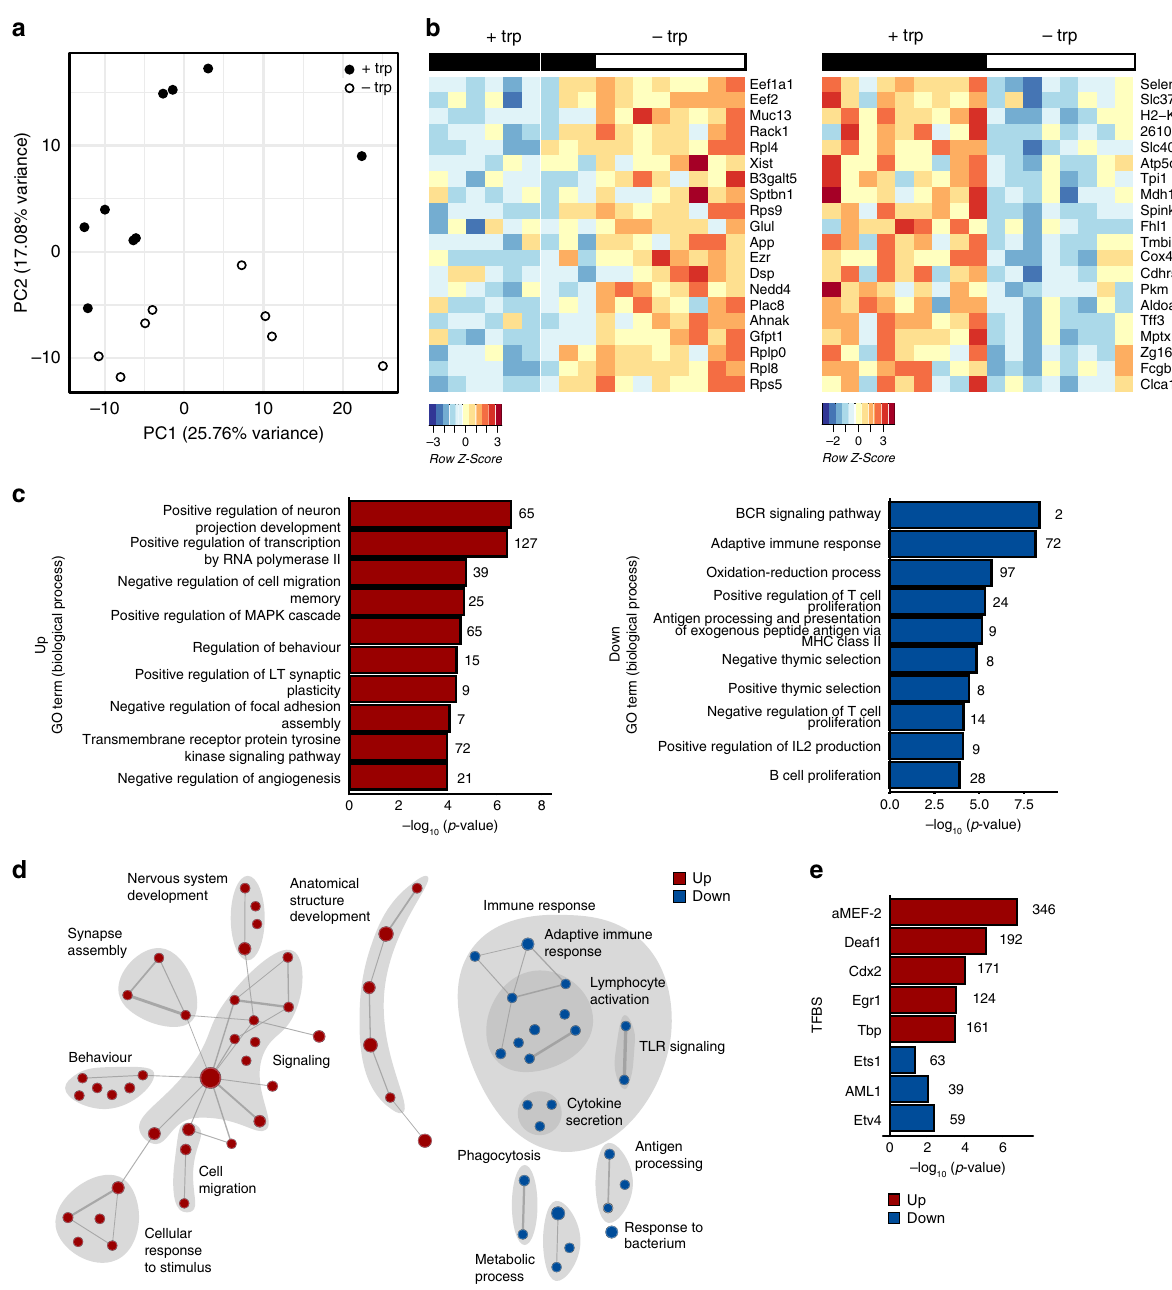
Fig. 6 DTR regulates key molecular signaling pathways in colon mucosa. a – e Total colon tissue (distal) of EAE mice from Fig. 5 was isolated on d14 for RNA sequencing ( + trp: n = 9; − trp: n = 9). a Principal component analysis (PCA) for RNA sequencing samples. b Heatmap of top 20 DEGs (up and down) in pair-wise comparisons between – trp and + trp. c Top 10 pathways (biological processes) of Gene Ontology (GO) enrichment analysis. d Enrichment map of regulated biological process GO terms. Each dot represents a signi fi cantly deregulated GO process, lines connect processes according to similarity of involved transcriptional modules. e TFBS analysis shows the enrichment of conserved transcription factor-binding sites in up- and downregulated transcripts. Source data are provided in Supplementary Data 5 –